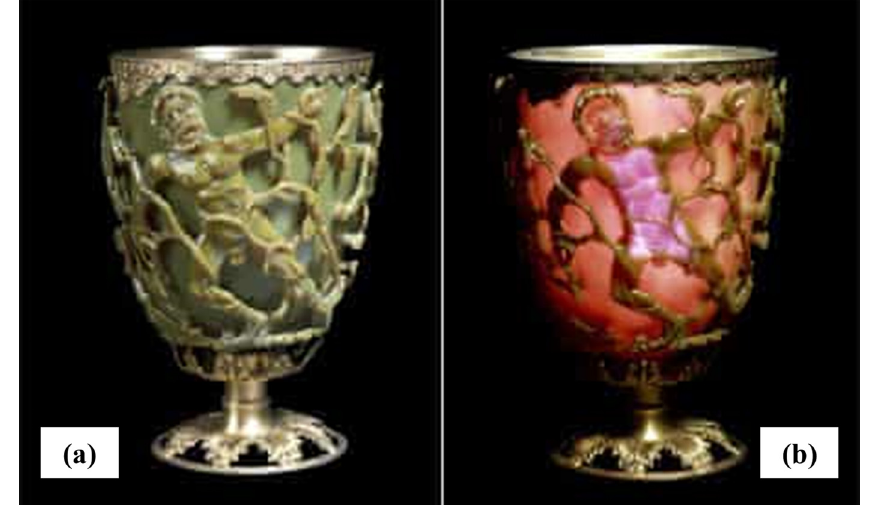
Figure 1: Portion of the Lycurgus cup with dichroic properties: ( a ) Opaque greenish yellow color under re fl ected light. ( b ) Translucent ruby - like color under transmitted light. Reproduced from ref. [ 10 ] , Copyright 2008, Springer -